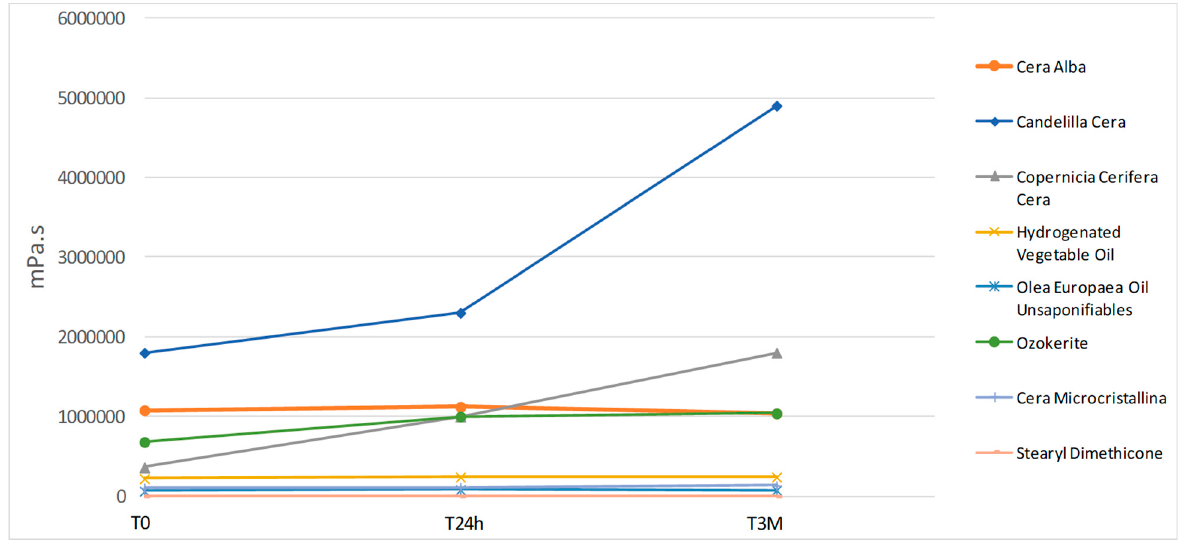
Figure 2. Trend of viscosity values at 2.5 rpm of 25% wax in oil gels at T0, T24, and after 3 months (at 0.5 rpm for Candelilla Cera). Table 6. Viscosity values of the new oil with blends of three waxes at T0, T24 h, and after 3 months.